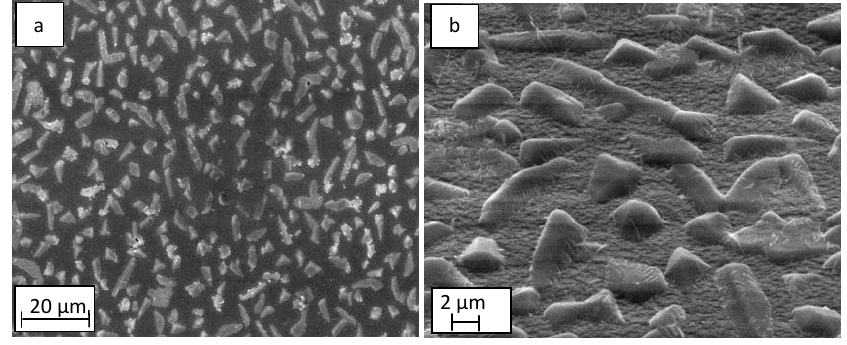
Figure 4. SEM micrograph of the surface of the titania sample, deposited onto float glass and